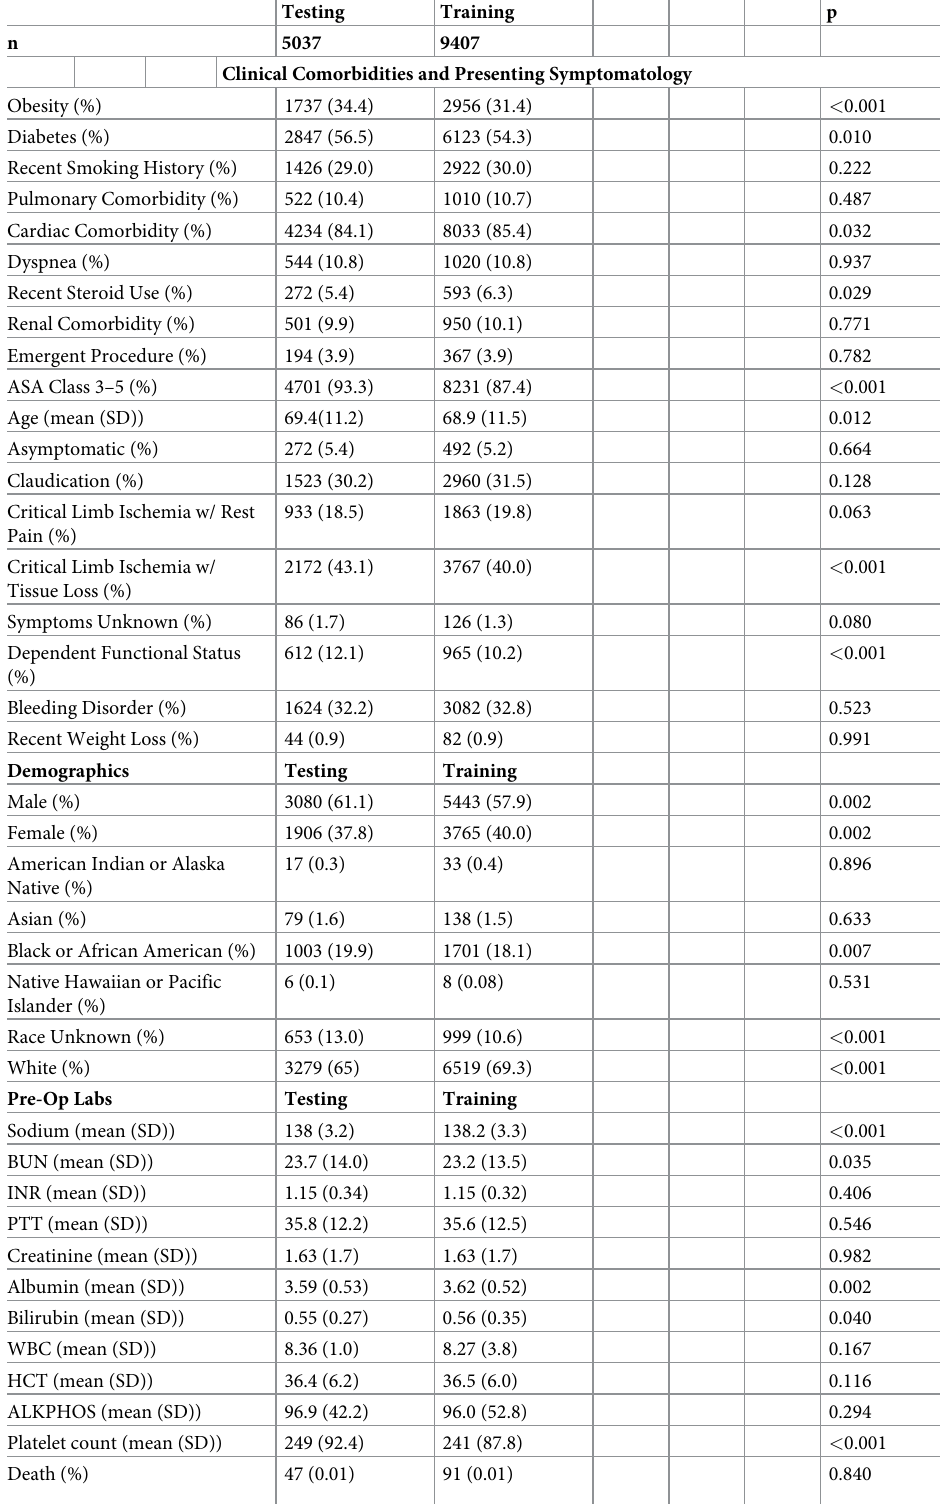
Table 1. Patient population